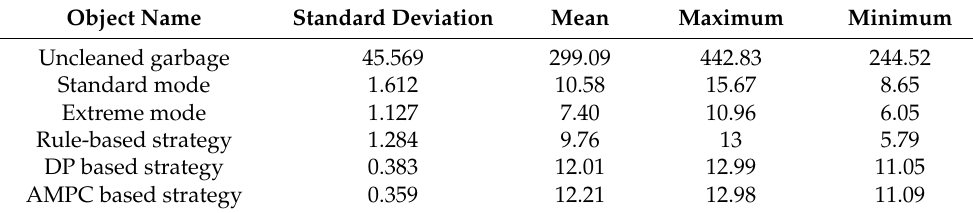
Table 5. Main statistical indicators of different strategies.